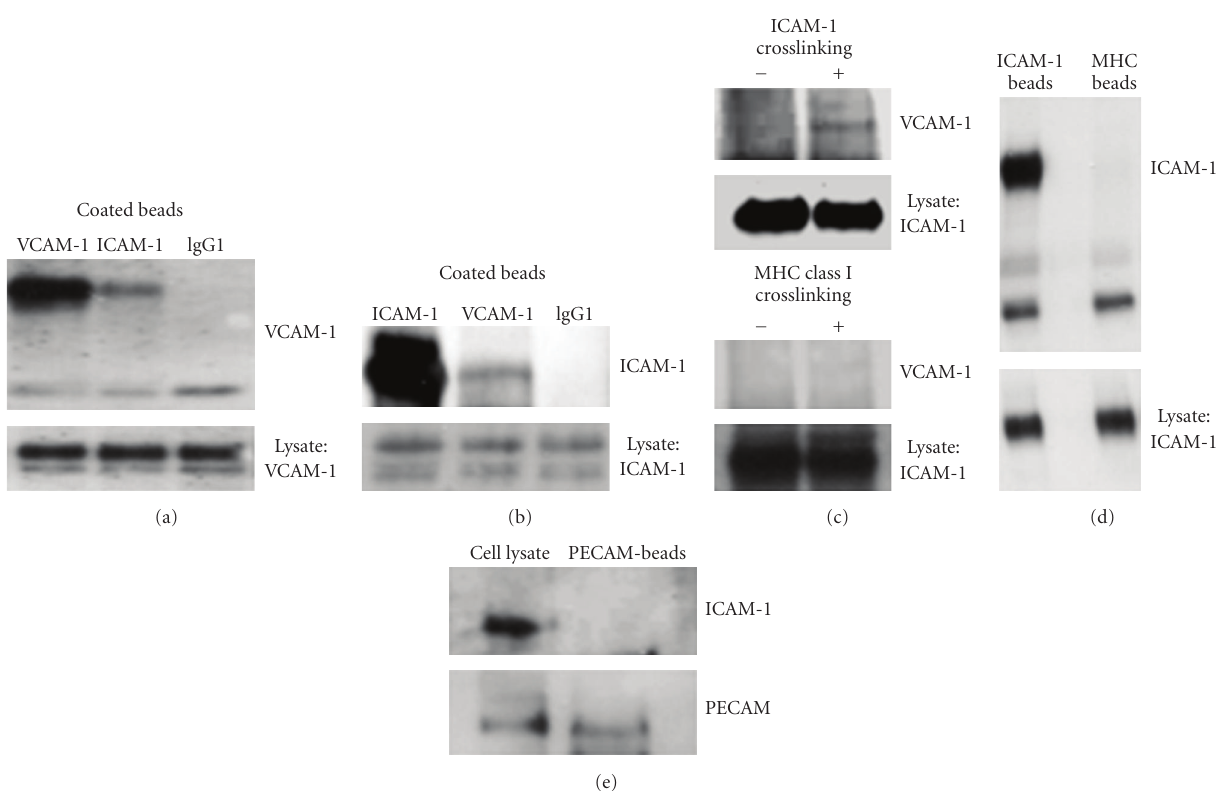
Figure 3: VCAM-1 associates with clustered ICAM-1. (a) Beads were coated with the indicated Abs as described in Section 2 and subsequently incubated with lysates from TNF α -treated HUVECs, followed by centrifugation, washing and analysis of bound proteins by SDS-PAGE and Western blotting. Blots were stained for VCAM-1 and show that VCAM-1 was precipitated with VCAM-1 beads and also with ICAM-1 beads. No VCAM-1 was detected in pull-downs using anti-IgG antibody coated beads. Lower panel shows expression of VCAM-1 in cell lysates as a loading control. Data are representative for three experiments. (b) The pull-down experiment was carried out as described under (a) and blots were stained for ICAM-1. ICAM-1 was precipitated with ICAM-1 beads, and a fraction of ICAM-1 associates with VCAM-1 beads, albeit less e ffi cient than the reciprocal experiment shown in (a). No ICAM-1 was detected in pull-down experiments using anti-IgG coated beads. Lower panel shows expression of ICAM-1 as loading control in cell lysates. Data are representative for three experiments. (c) TNF α -stimulated HUVECs were incubated with ICAM-1 Ab in solution for 30 minutes and subsequently crosslinked with secondary antimouse Ab for an additional 30 minutes. Cells were lysed and ICAM-1 was immunoprecipitated and analyzed by Western blotting, which shows that ICAM-1-clustering induced association with VCAM-1. Lower panel shows ICAM-1 expression in cell lysates. Bottom panel shows that crosslinking of MHC class I protein did not induce any binding of VCAM-1. (d) ICAM-1 is precipitated by ICAM-1 beads, but not by anti-MHC class I antibody coated beads. Lower panel shows expression of ICAM-1 in cell lysates. (e) No ICAM-1 is precipitated by anti-PECAM-1 antibody coated beads (upper panel). Lower panel shows precipitation of PECAM-1 with the